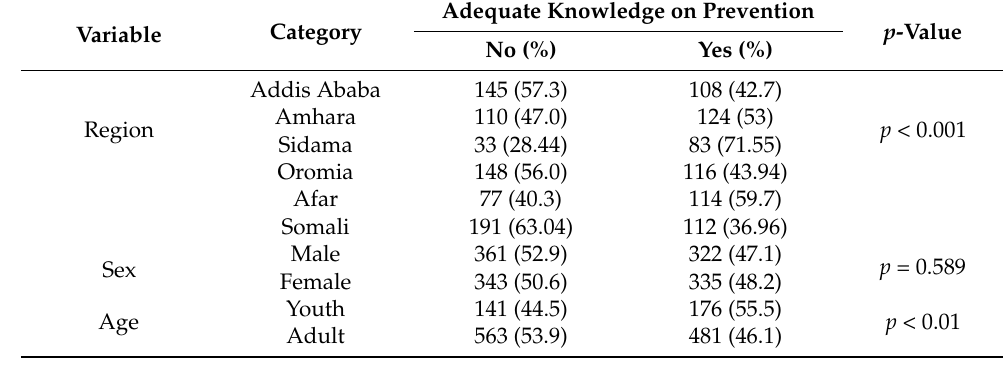
Table 3. Level of knowledge by region, sex, and age regarding COVID-19 prevention methods at the time of the COVID-19 hesitancy survey in Ethiopia, 2022.